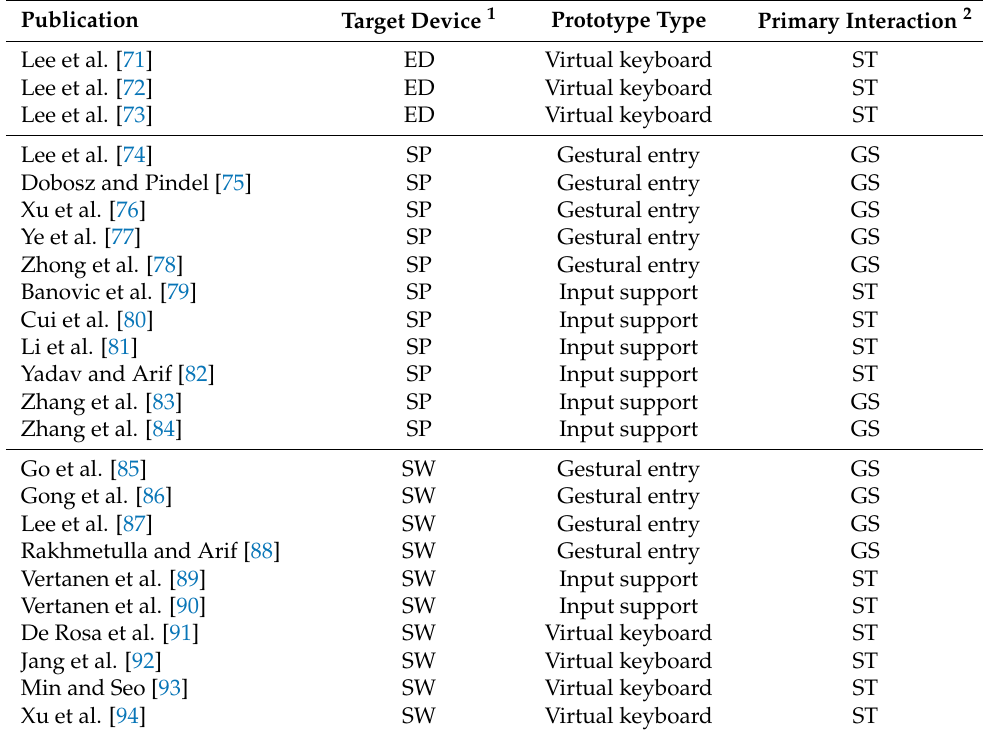
Table 5. Input method characteristics (studies with non-impaired